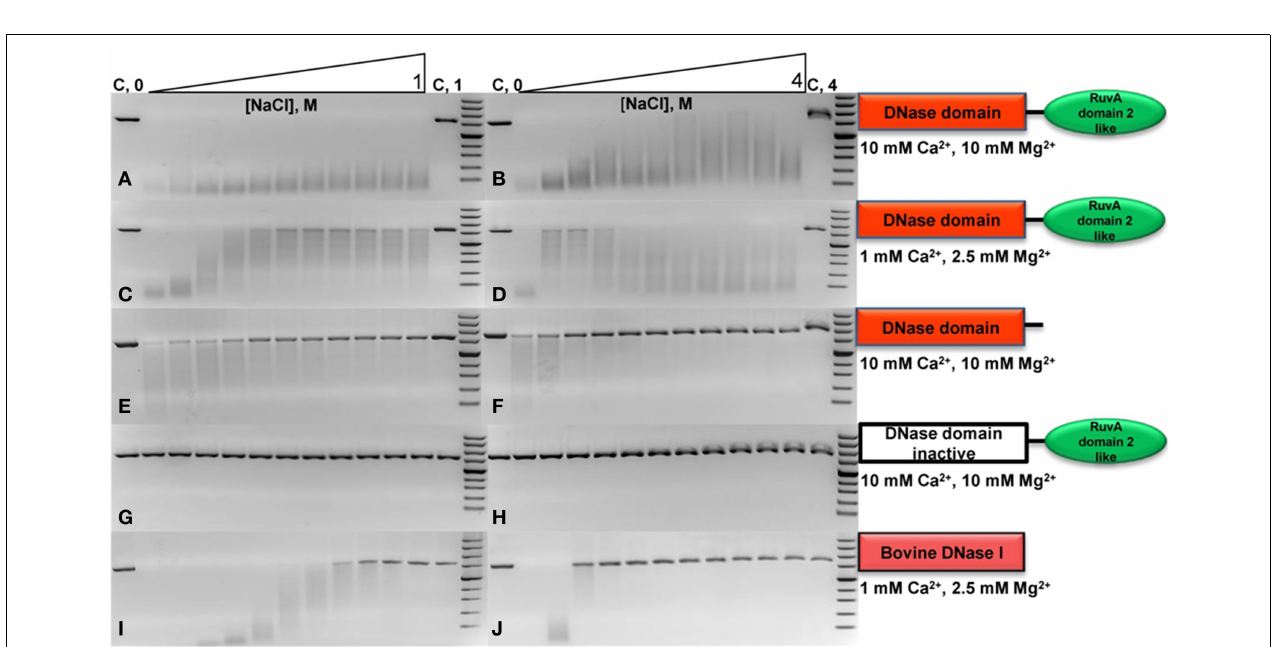
that both enzymes require Ca 2 + and Mg 2 + for activity, however, DNaseTA requires significantly higher concentrations. The optimal concentrations are ∼ 10 mM Ca 2 + and ∼ 10 mM Mg 2 + for DNaseTA and, respectively, ∼ 1 mM and ∼ 2.5 mM for bovine DNaseI.